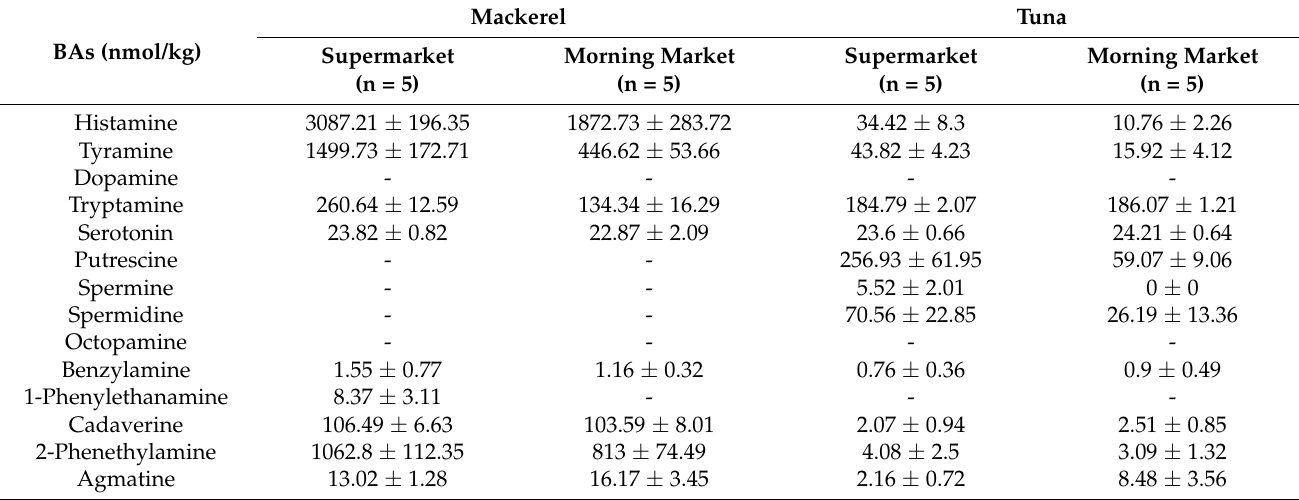
Table 4. The content comparison of biogenic amines in fish from a morning market and